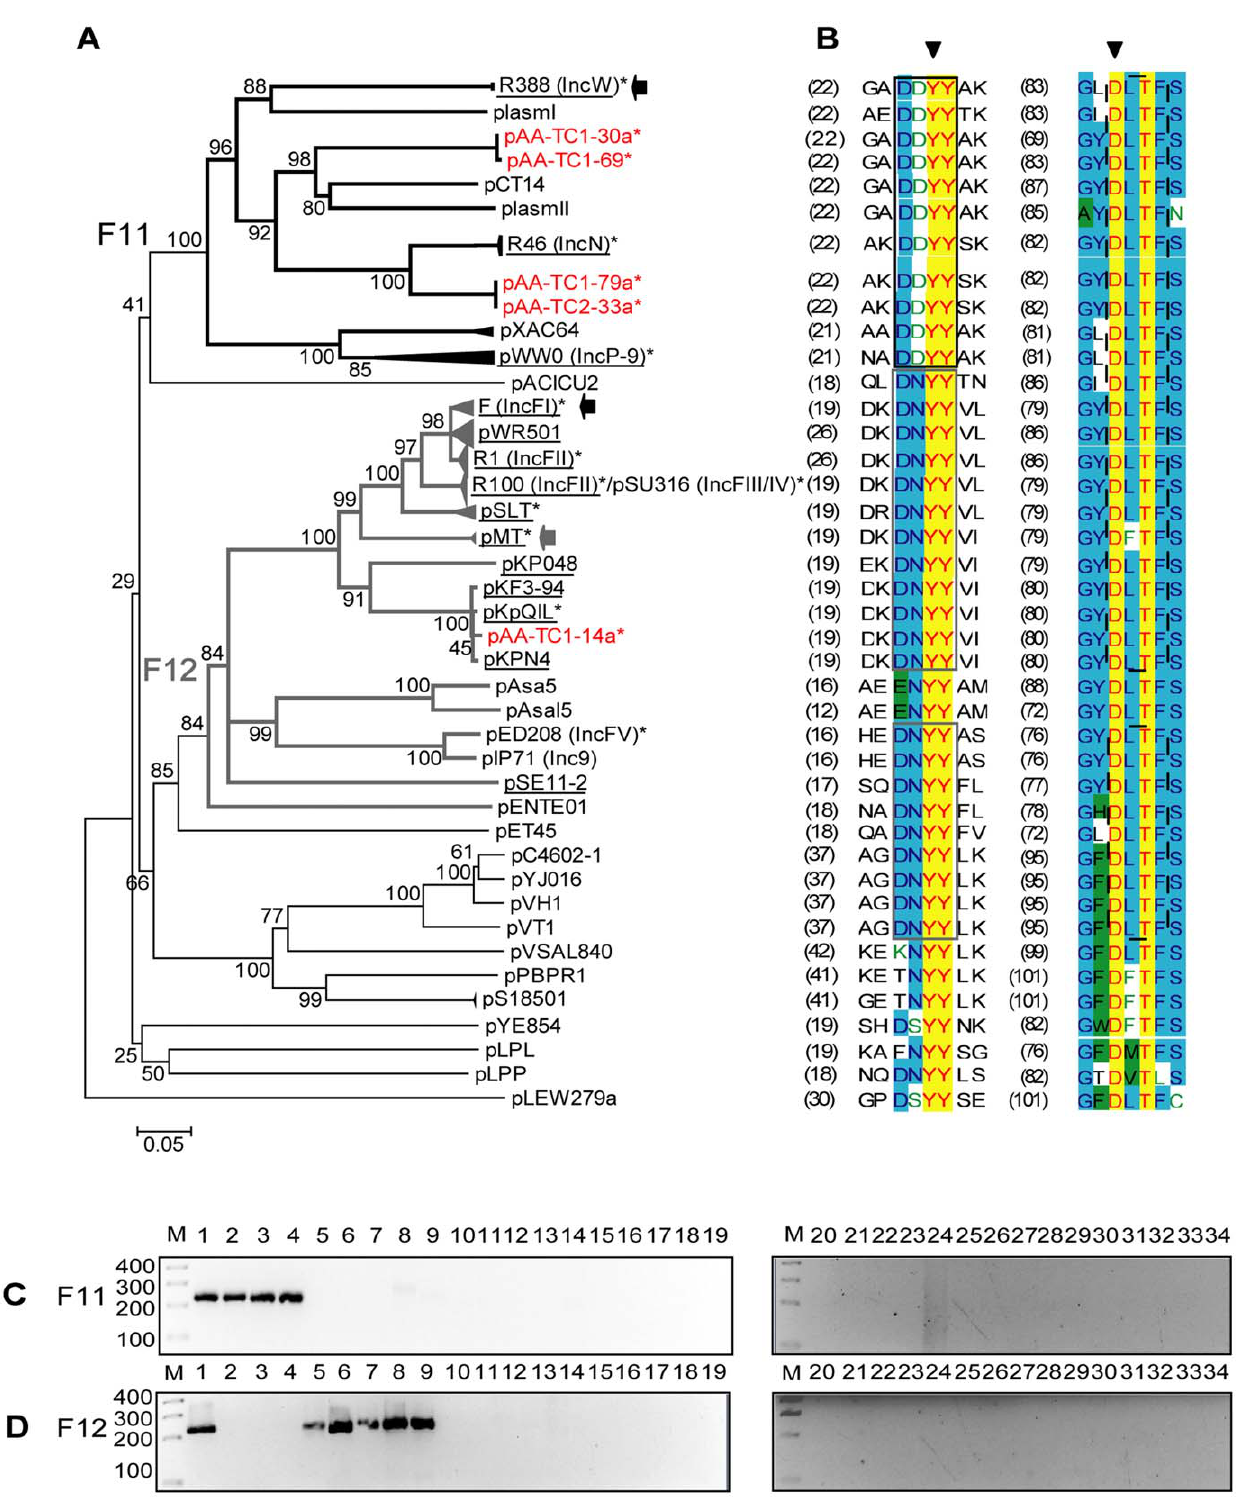
Figure 1. DPMT validation for MOB F relaxases. A) Phylogenetic tree of MOB F relaxases. Triangles at the end of the branches represent a compressed group of very similar relaxases ( . 95%). A solid black arrow points to the prototype plasmid for each subfamily. Arrows point to plasmids that experimentally amplified, in spite of containing at least one mismatch in the 12 nucleotides of the CORE sequence. Relaxases contained in our reference collection (Table 1) are denoted by an asterisk. Plasmids detectable by PBRT amplification [19,20,21,22,24,25,27,28,29] are underlined. New relaxase sequences uncovered by DPMT are shown in red. B) Alignment of the relaxase motifs used to design the MOB F degenerate primers. Colour code: red on yellow = invariant amino acids; blue on blue = strongly conserved; black on green = similar; green on white = weakly similar; black on white = not conserved. Black arrowheads point to the key residues that define the relaxase motifs. Different rectangles embrace the conserved